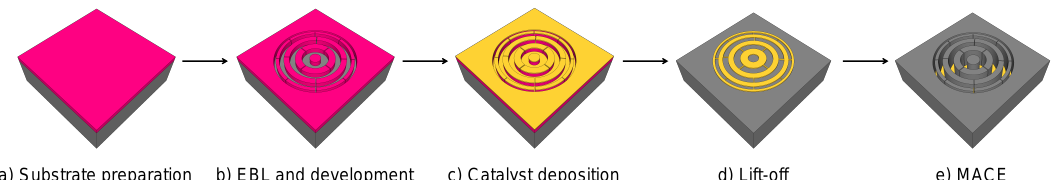
Figure 2. Overview of the experimental procedure. ( a ) Si substrate (grey) preparation by spin-coating 80 nm CSAR 62 resist (pink). ( b ) Zone plate patterning by EBL and development for removal of resist residues. ( c ) Deposition of 2 nm Ti and 10 nm Au (yellow) by evaporation. ( d ) Resist lift-off, leaving the metal zone plate pattern. ( e ) Etching the metal zone plate pattern into the Si via MACE.